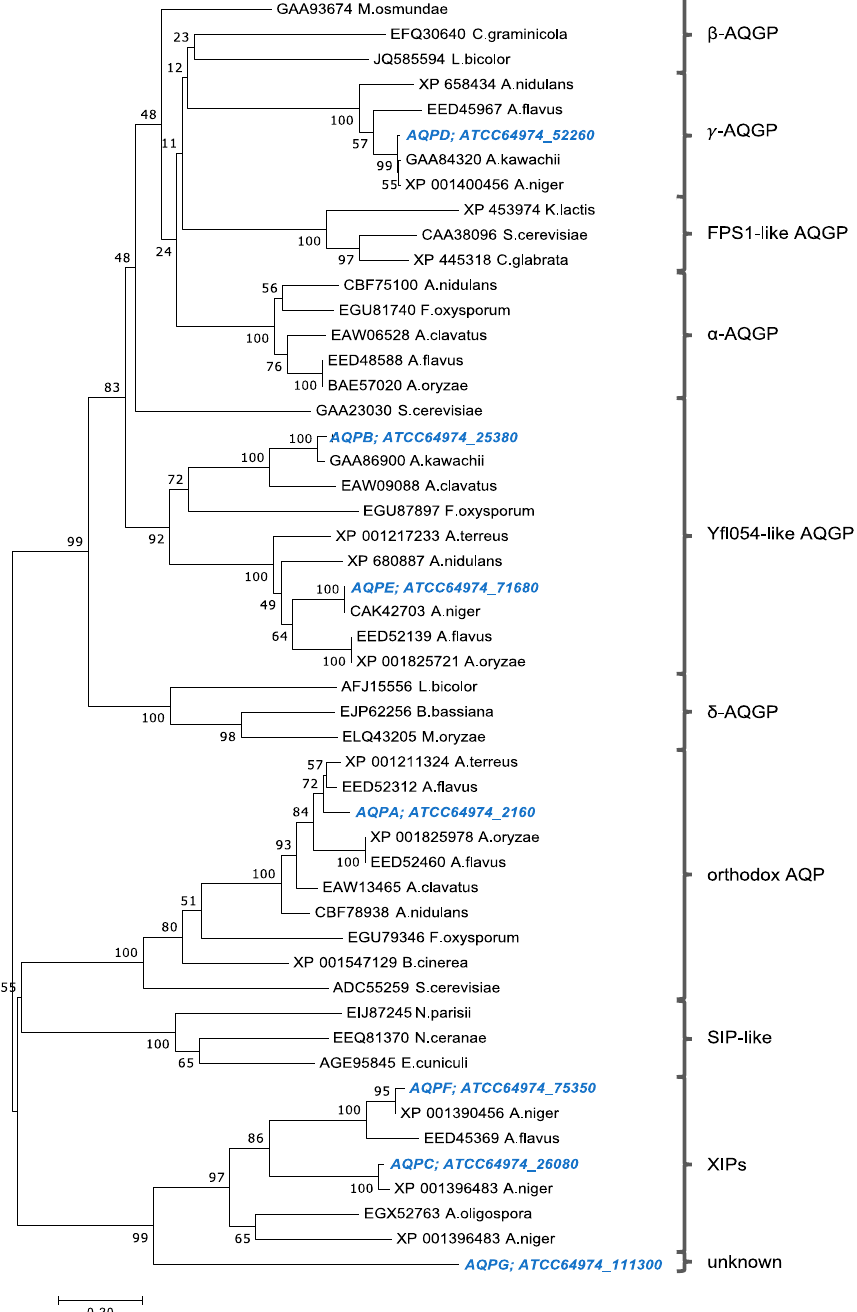
Figure 1. Classification of A. niger N402 AQPs. Sequences were aligned with ClustalX. The dendro- gram was constructed by neighbor-joining analysis. A niger N402 sequences are indicated in blue. Number nodes indicate bootstrap support following 1000 iterations.